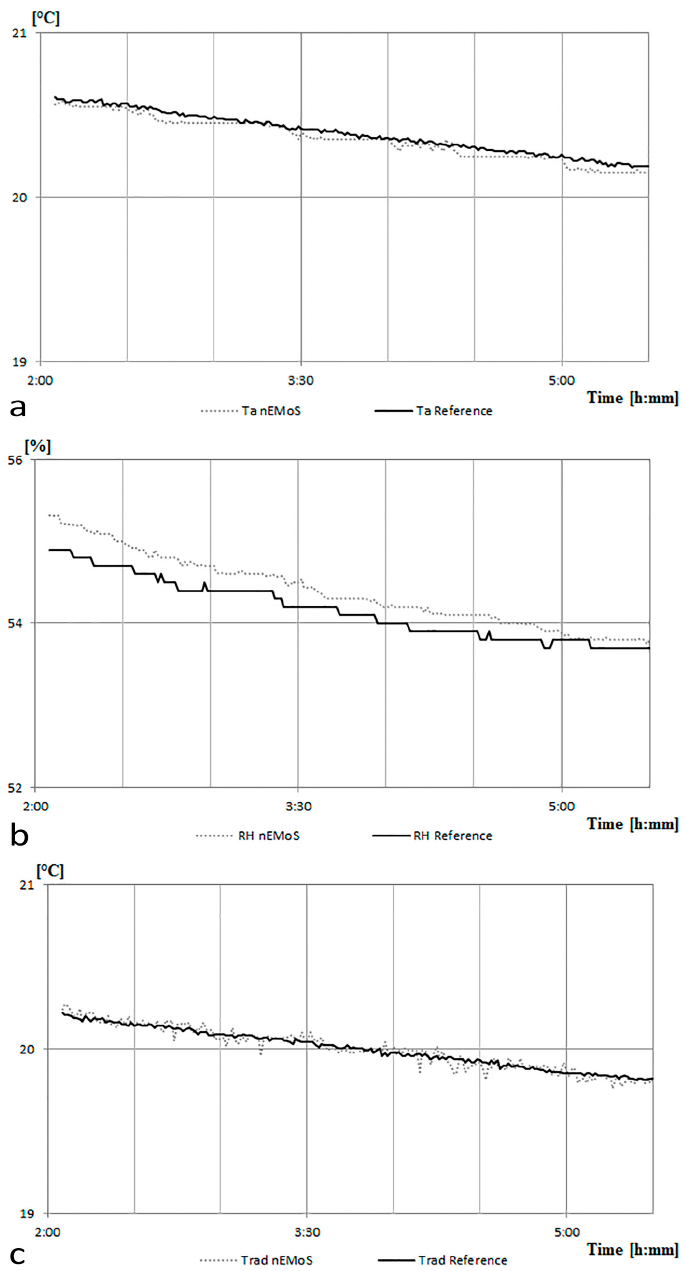
Figure 10. nEMoS Case vs reference sensors: ( a ) air temperature (Ta) data; ( b ) relative humidity (RH) data; and ( c ) radiant temperature (Trad) data.